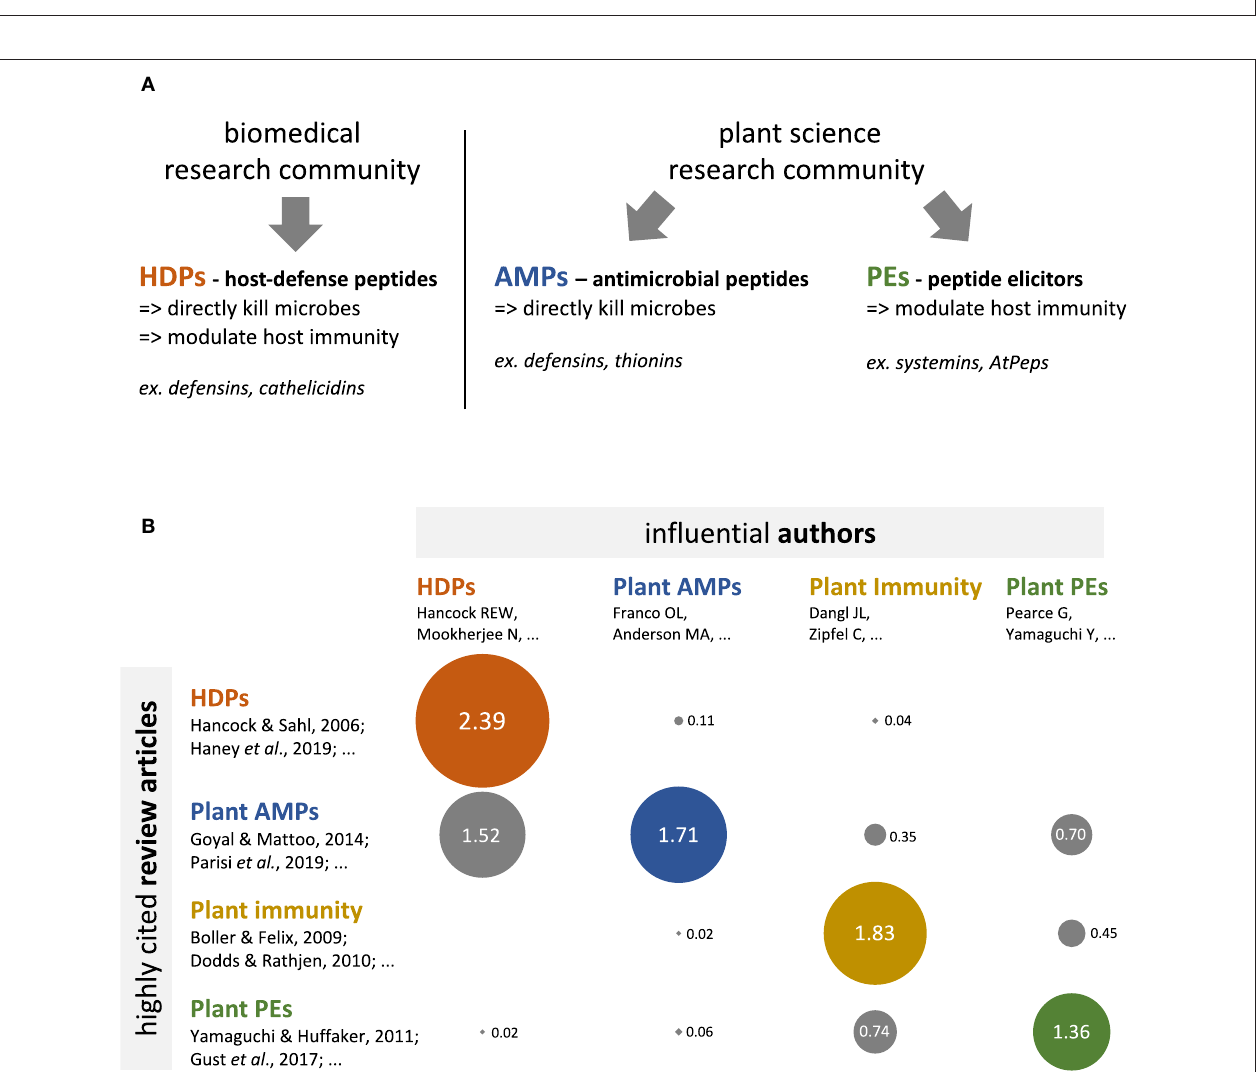
Frontiers in Immunology |